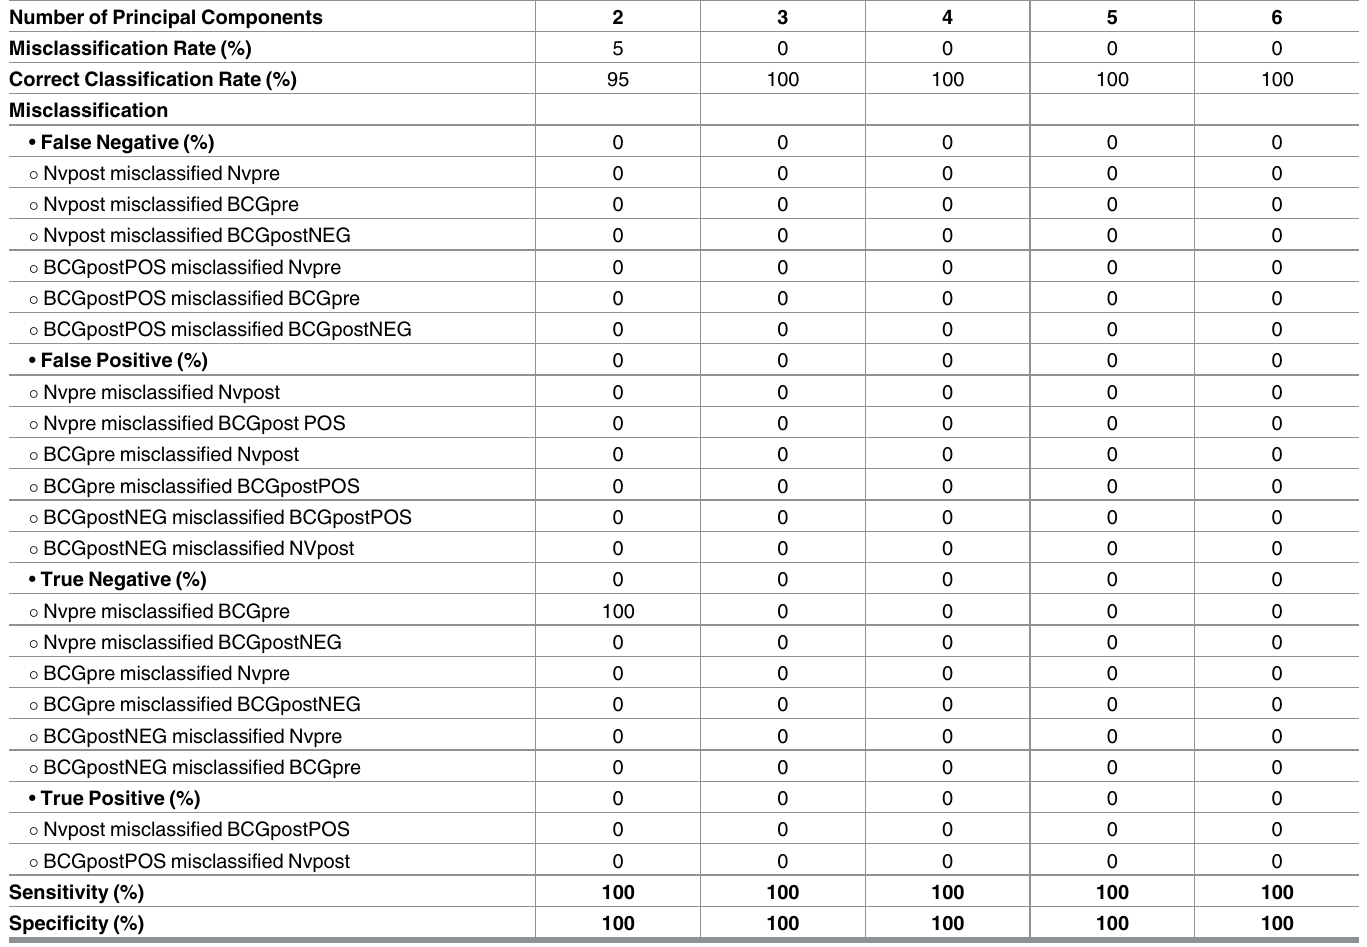
Table 2. Linear discriminant analysis classification of calvesusing statistically significant